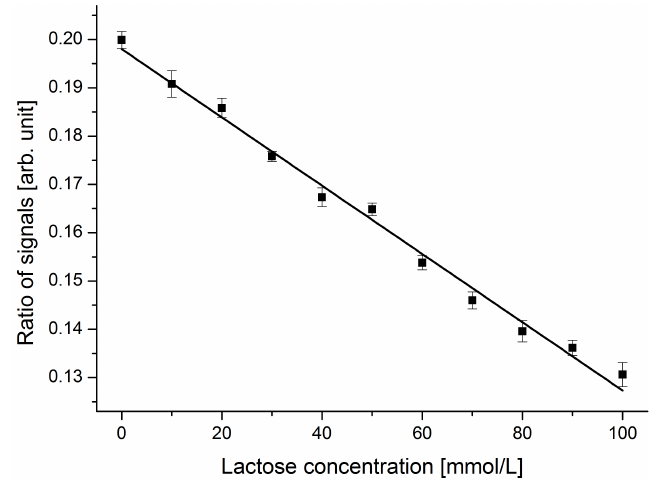
Figure 7. Response of the sensor device to dissolved lactose in DI water in the range from 0 to 100 mmol/L. Samples with different lactose concentrations in a step size of 10 mmol/L can clearly be discriminated. Concentration errors and laser power stability issues explain the small deviations from the fitted linear curve.